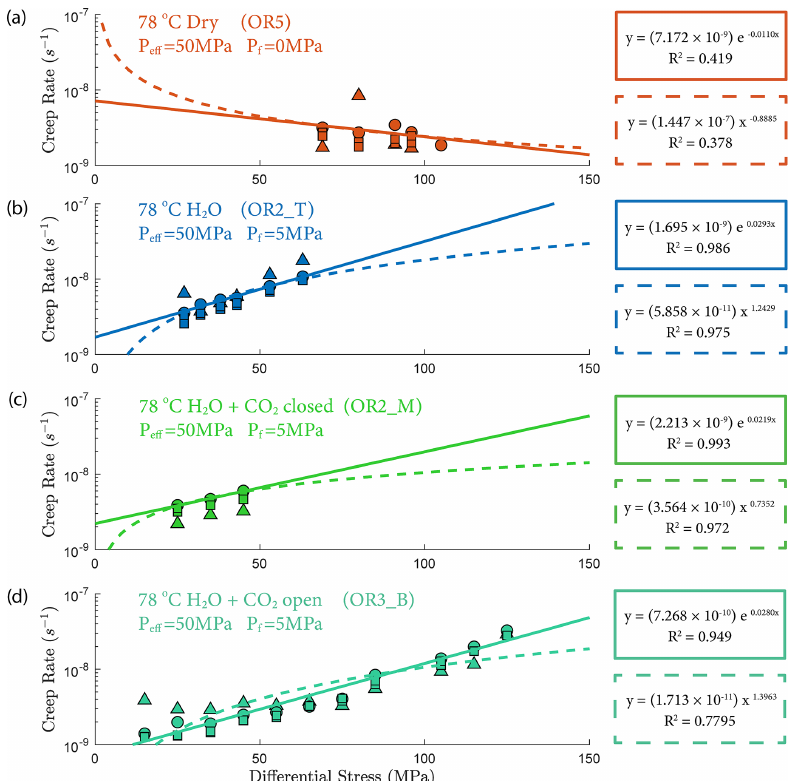
Figure A6. Power-law (dashed line) and exponential (solid line) fit of creep rate–stress relationship. The strain rates are calculated from strain measurement from the main ram displacement (circle), strain gauge (triangle) and LVDTs (square).